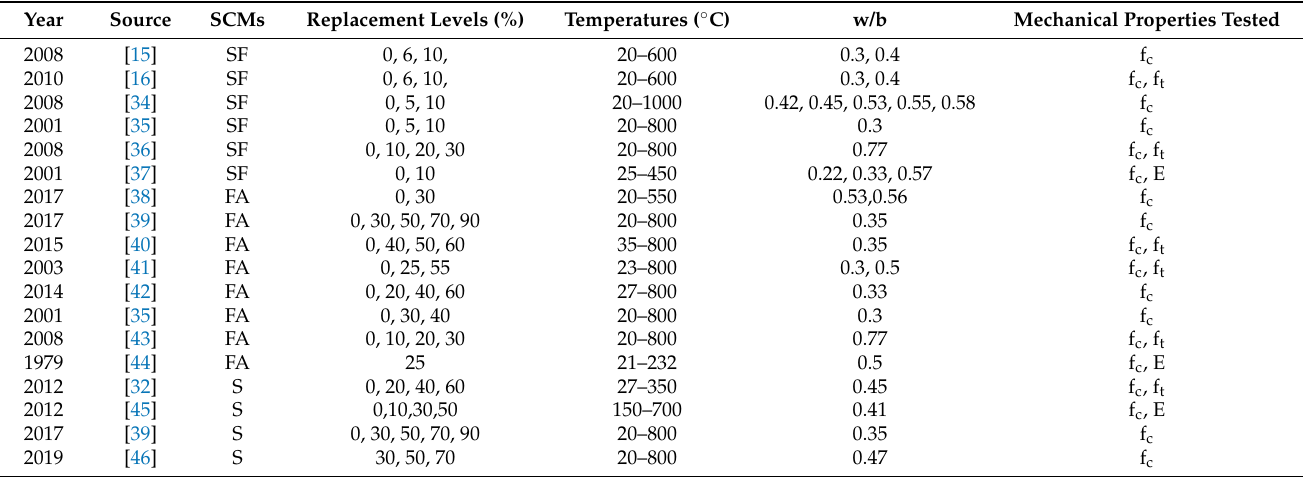
Table 2. Summary of research on the effects of SCMs on concrete exposed to high